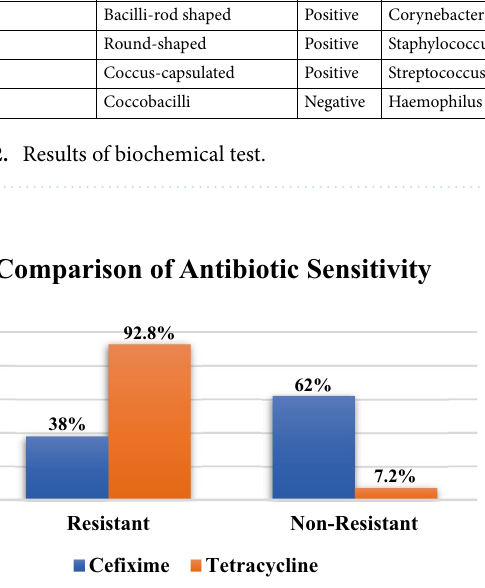
Figure 1. Total percentage of cefexime and tetracycline resistance test against bacterial